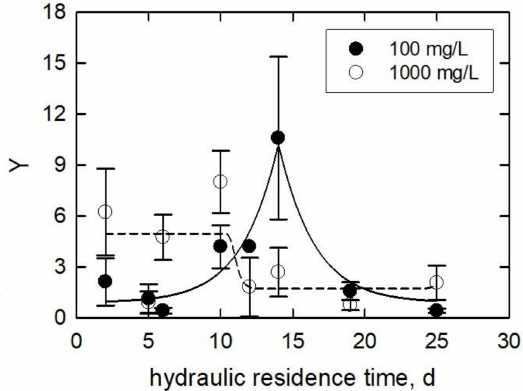
Figure 7. Normalized specific chlorophyll a plotted against the hydraulic residence time of the continually stirred tank reactors in which the algae inoculums were cultured. Lines are fitted using Equation